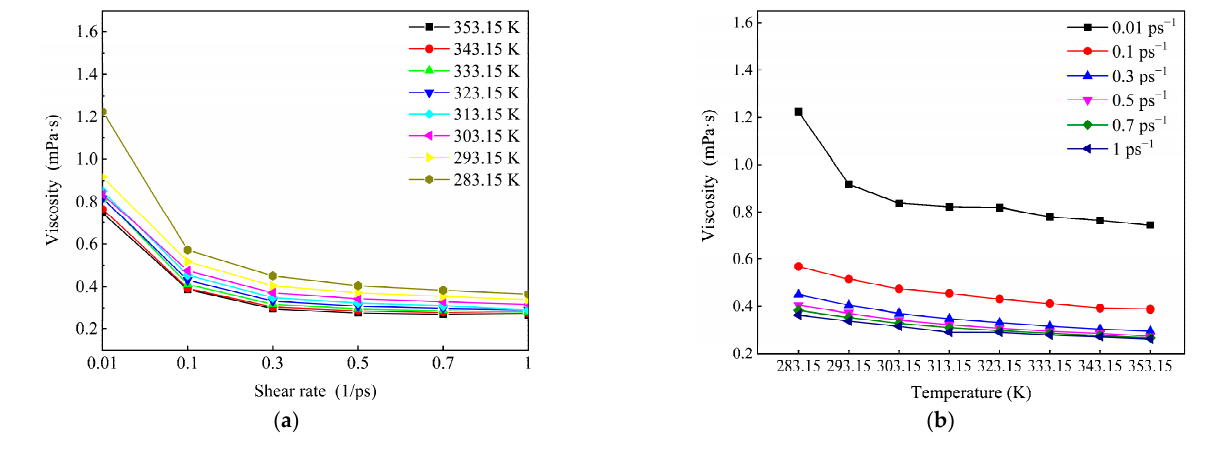
Figure 13. Effect of temperature on the viscosity of the system during shearing. ( a ) Variation in shear viscosity with shear rate; ( b ) variation in shear viscosity with temperature.